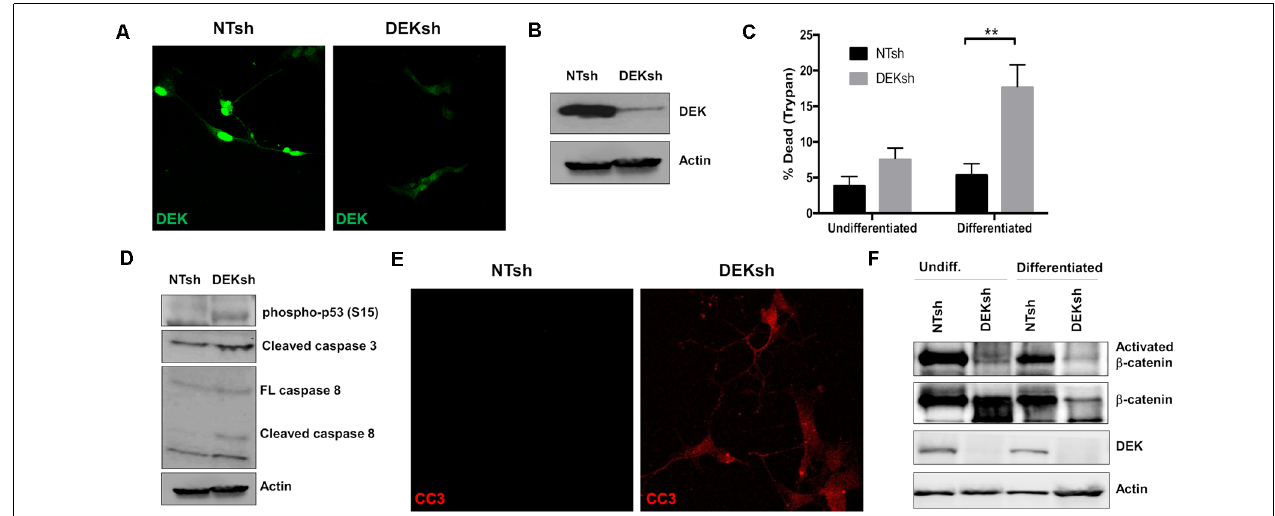
FIGURE 1 | DEK knockdown in SH-SY5Y cells increases cell death via apoptosis. (A,B) DEK is successfully knocked down in SH-SY5Y cells using an shRNA lentiviral construct. A non-targeted shRNA (NTsh) was used as a control. (C) Number of dead cells were counted using Trypan blue. Neuronal differentiation exacerbated cell death due to DEK loss (** p < 0.01). (D) DEKsh cells showed increased phosphorylated p53 and cleaved caspase 3 (CC3) and 8, indicative of apoptosis. (E) Representative immunofluorescence images display increased CC3 in DEKsh cells. (F) Total β -catenin expression levels decreased in differentiated DEKsh cells. Activated β -catenin is downregulated in both undifferentiated and differentiated DEKsh